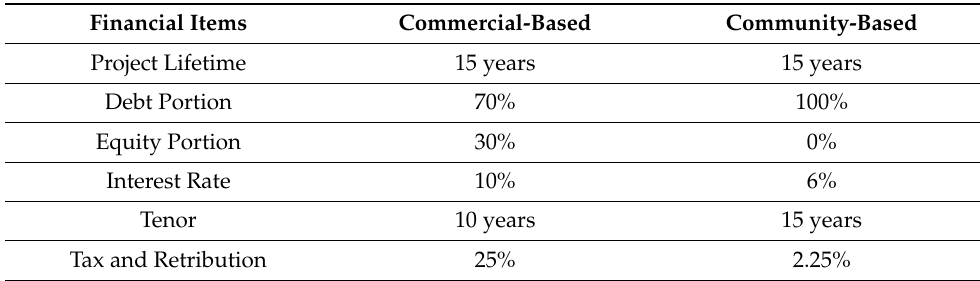
Table 5. The comparisons of Financial Instrument from both Ownership Models.